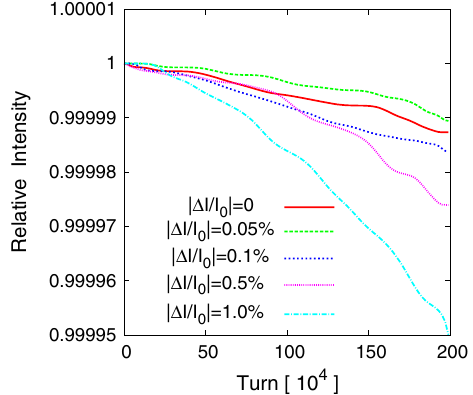
FIG. 22. Relative proton beam loss versus the random noise in the electron beam current. The relative noise ratio j (cid:1) I=I 0 j is defined as the maximum amplitude of random noise in the electron current divided by the nominal current.